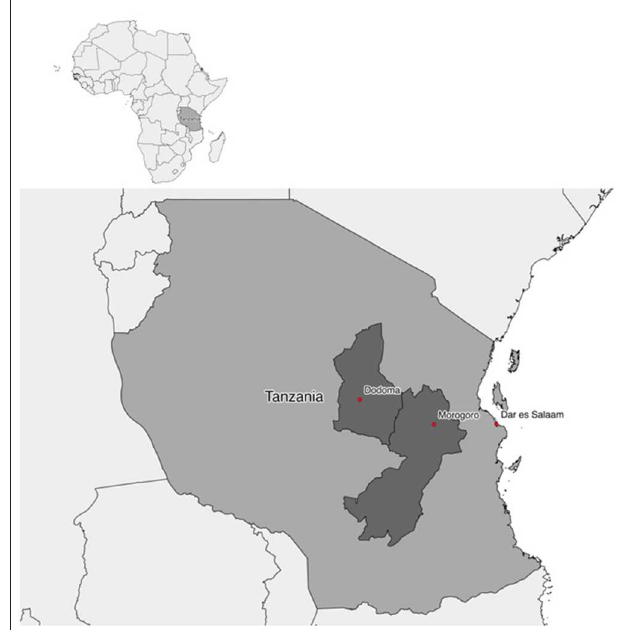
FIGURE 1 | Map showing Tanzania within Africa, then Dodoma and Morogoro regions/Chamwino District, within Tanzania. Source: Scale-N project.